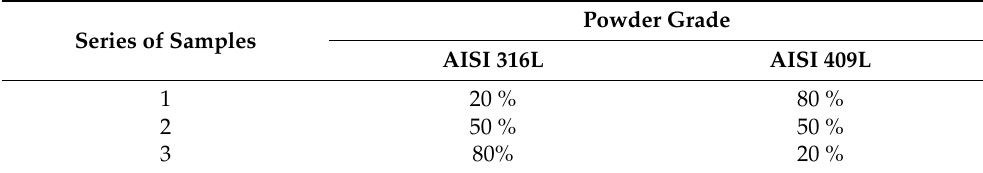
Table 2. Percentages of powders in each series of samples (%